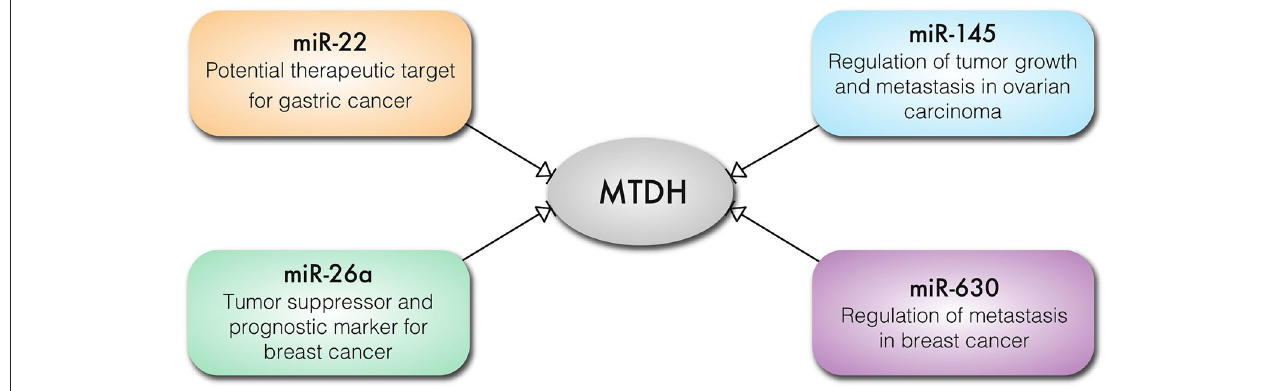
FIGURE 4 | Key cancer related miRNAs that regulate the expression of MTDH in different types of cancer cells.